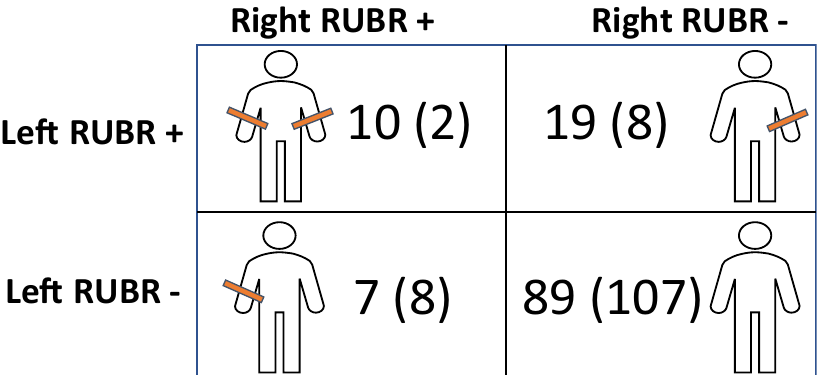
Table 3. Intraindividual analysis of DVA in right vs. left RUBR. In 125 patients, difficult vascular anatomy (DVA) could be assessed bilaterally in RUBR, either during the same procedure (n = 30) or during subsequent procedures (n = 95) allowing for intraindividual comparisons. Pairwise counts represent DVA and 2nd degree DVA (in brackets). RUBR radial-ulnar-brachial region.